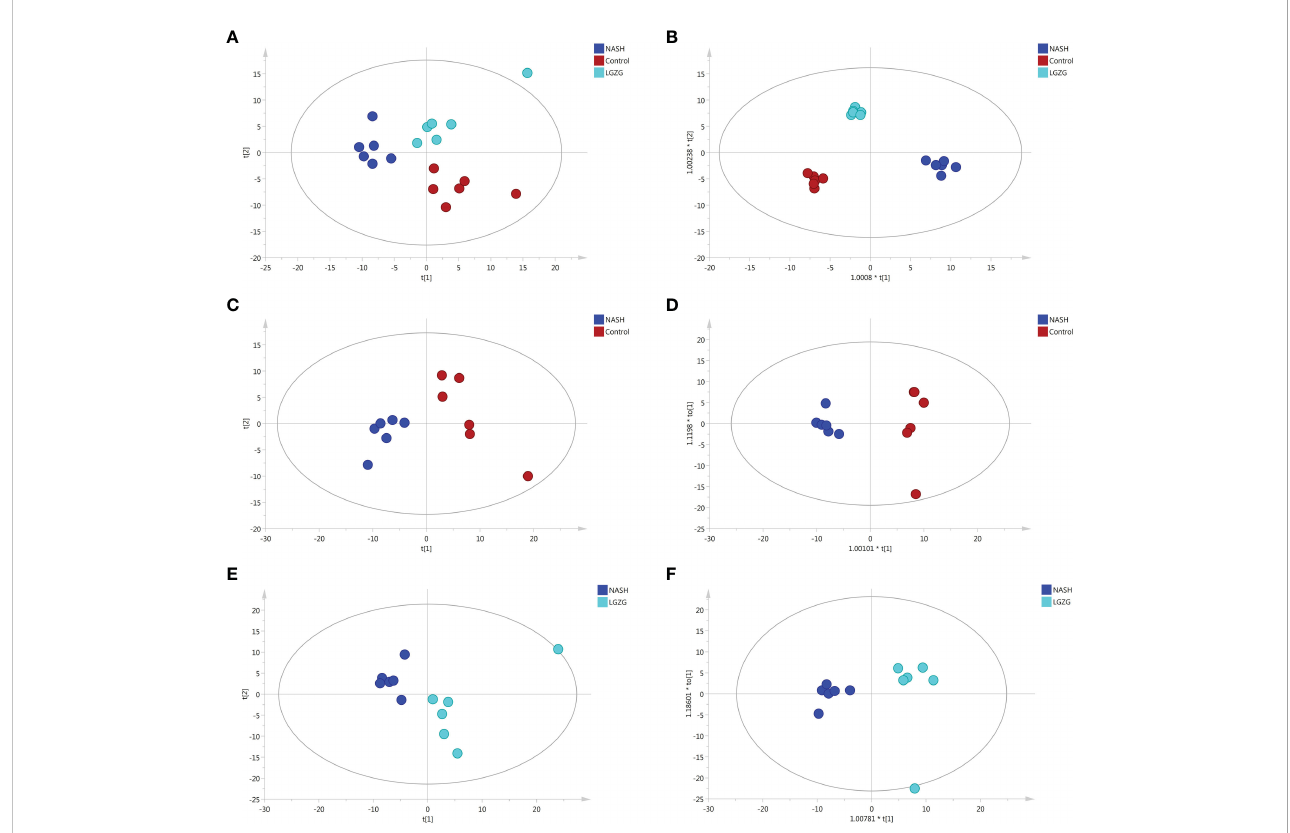
FIGURE 5 PCA and OPLS-DA plots across groups. (A) PCA plots among the Control, NASH and LGZG groups, (B) OPLS-DA plots among the Control, NASH and LGZG groups, (C) PCA plots between the Control and NASH groups, (D) OPLS-DA plots between the Control and NASH groups, (E) PCA plots between the LGZG and NASH groups, (F) OPLS-DA plots between the LGZG and NASH groups; red dots indicated samples in the Control group, blue dots indicated samples in the NASH group and green dots indicated samples in the LGZG